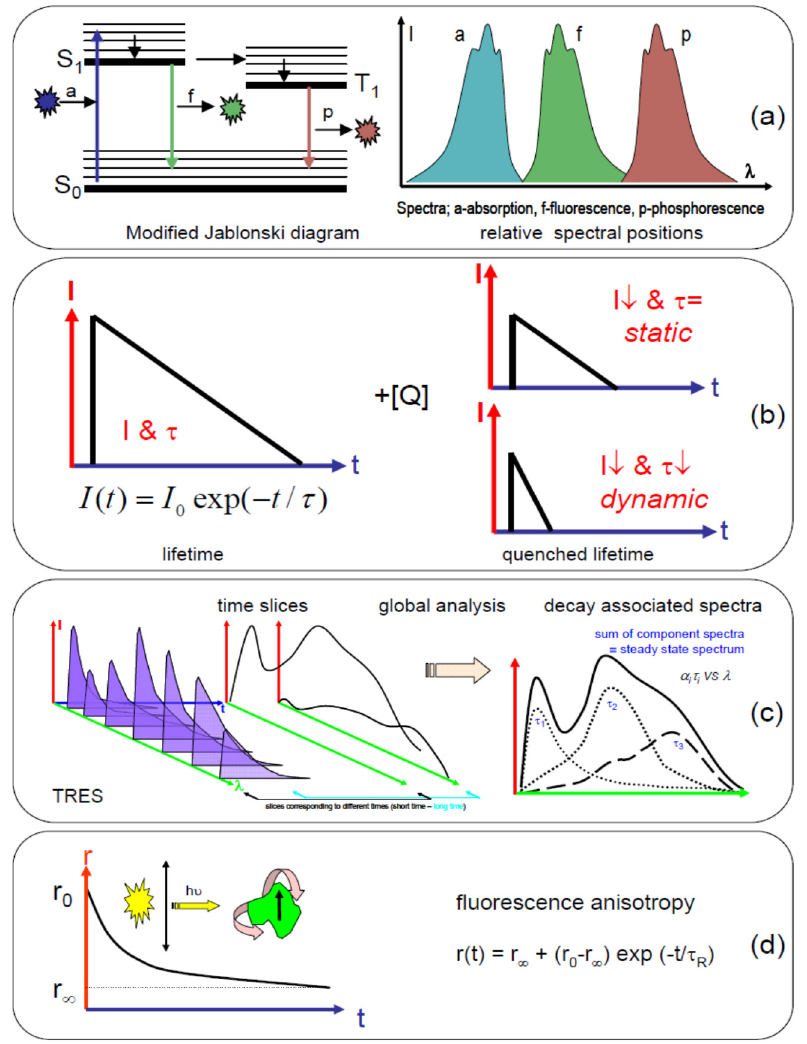
Figure 1. Graphical depiction of time-resolved measurement methods and an indication of the information obtainable. ( a ) A modified Jablonski diagram, plus a relative indication of the wavelength positions of the absorption, fluorescence and phosphorescence spectra; ( b ) Representation of a decay (log intensity scale) and variation of lifetime ( τ , indicated by gradient of decay) and intensity (I) on addition of a quencher ([Q]); ( c ) Time-resolved emission spectra (TRES) illustrating time slicing at two points and production of decay associated spectra; ( d ) Representation of fluorescence anisotropy, which can provide the initial anisotropy (r 0 ), the limiting anisotropy (r ∞ ) and the rotational correlation time ( τ R